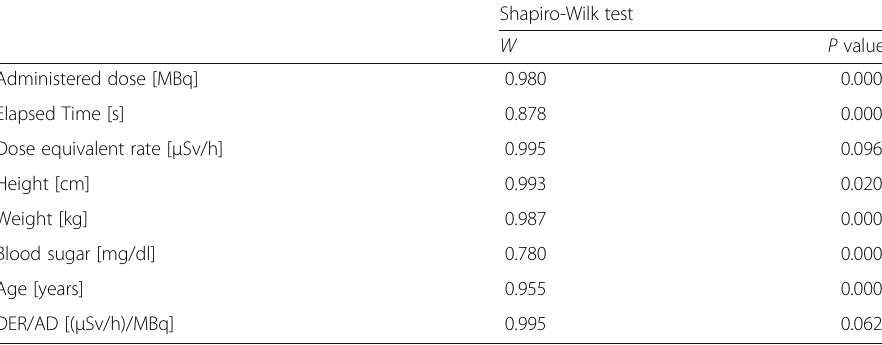
Table 2 Shapiro-Wilk test of variables